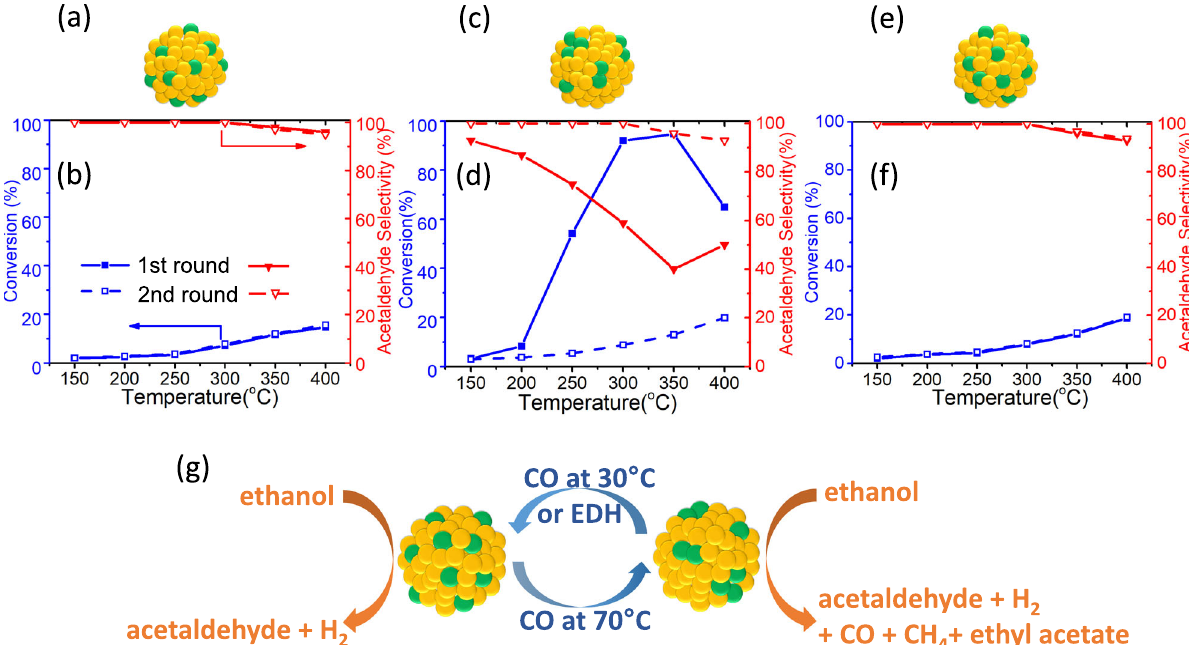
Fig. 4 In situ control over a reaction pathway via CO treatment. Structure ( a , c , e ) and catalytic performance ( b , d , f ) of a Pd 0.02 Au 0.98 /SiO 2 sample after ( a , b ) no CO treatment, ( c , d ) CO at 30 °C for 30 min then 70 °C for 30 min which causes Pd to form clusters, ( e , f ) CO treatment at 30 °C for 30 min, then 70 °C for 30 min, then 30 °C for 1 h which causes Pd to aggregate and then re-disperse back into atoms. g Schematic illustration showing how CO treatment can be used to change Pd from atoms to clusters and back, and the effect of these different active sites on reaction pathway. Ethanol dehydrogenation (EDH) reaction conditions: 300 mg catalyst, 2% ethanol in helium, total fl ow rate 12 mL/min, GHSV = 2400 mL/(h ∙ g cat ). Each temperature was held for 2 h. The solid line shows the fi rst-round EDH reaction from 150 °C to 400 °C; the dotted line is the second round reaction. Each point is the average of data obtained during 2